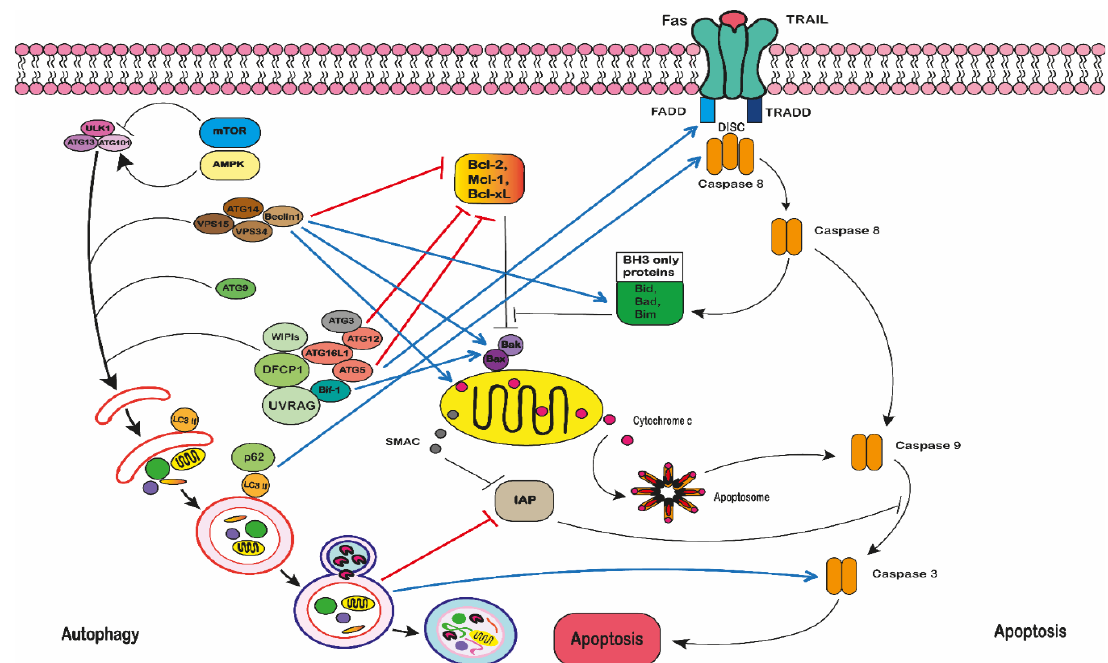
Figure 8. Autophagy mediates programmed cell death. The extensive proteins and pathways crosstalk between autophagy and apoptosis, which include the Beclin 1-BCL-2 interaction; caspase-mediated Beclin 1 cleavage; ATG12- ATG3 conjugation; ATG12-Mcl-1 interaction; ATG5-FADD interaction. Red lines represent inhibitory interactions, while blue lines with arrows represent stimulatory interactions.